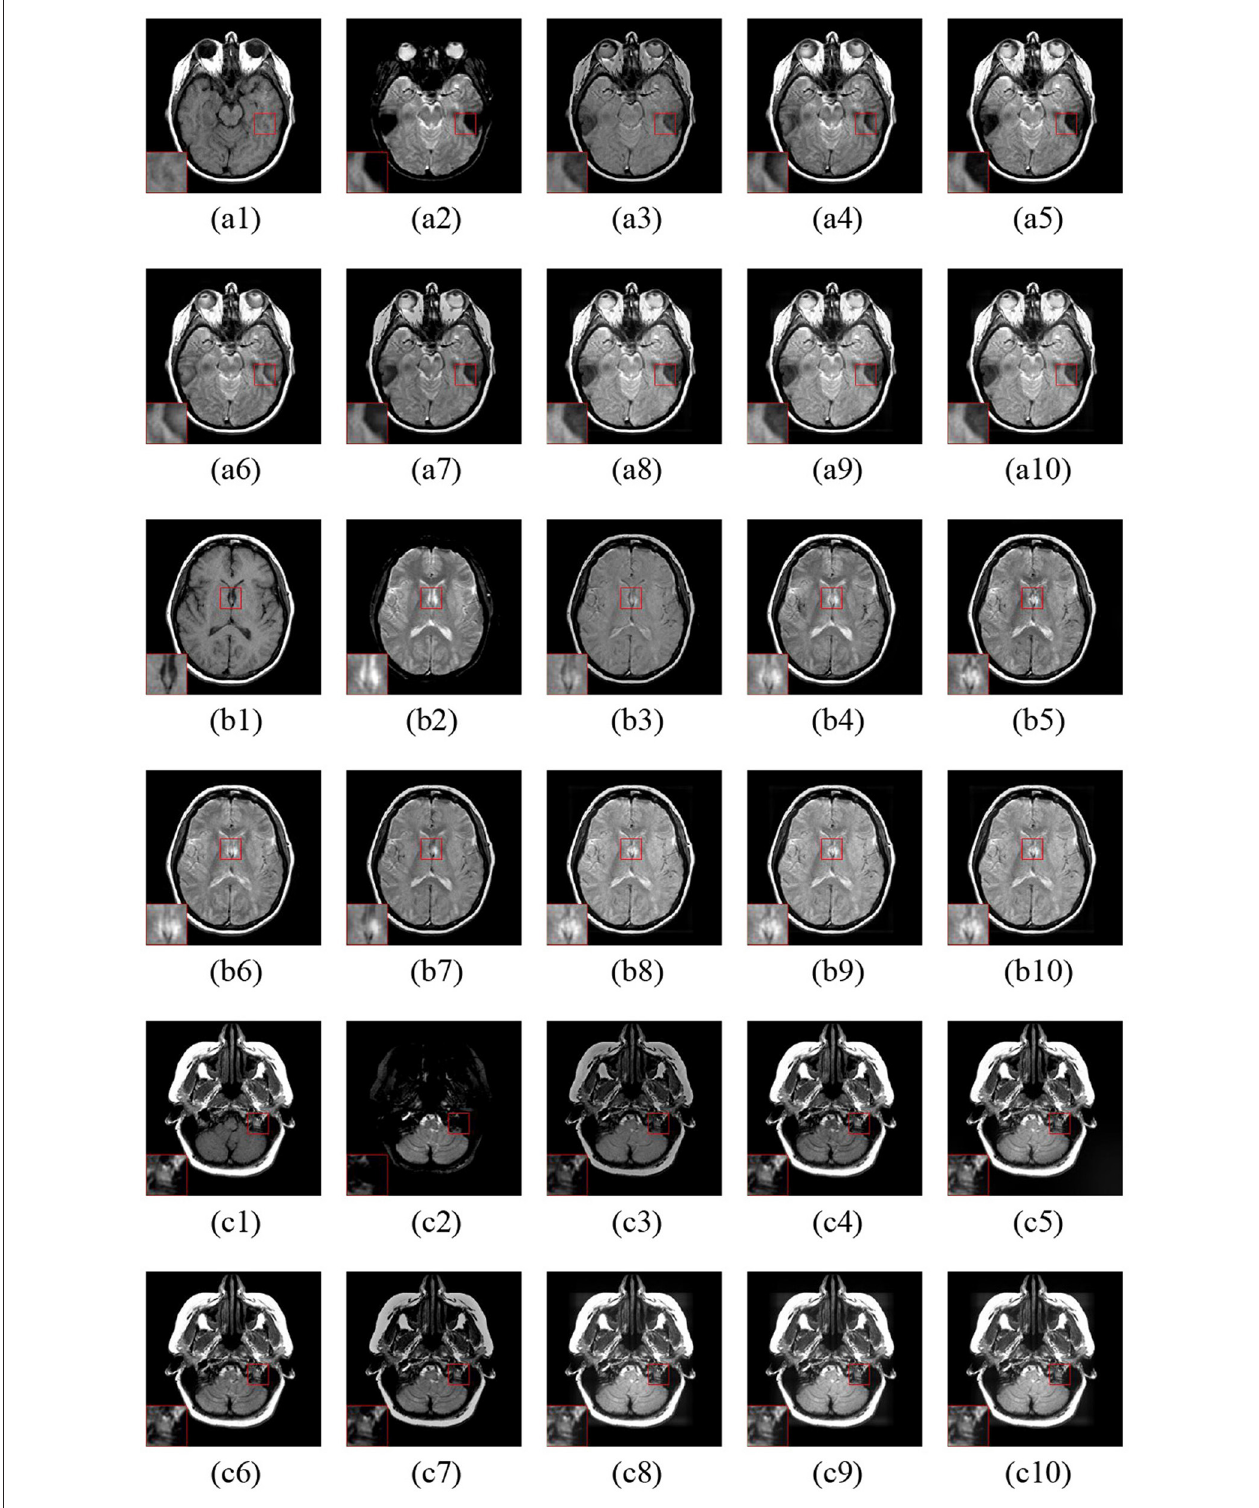
FIGURE 7 | Three fusion examples of MR-T1 and MR-T2 images. One close-up is provided in each set for better comparison. The original images: (a1–c1) MR-T1 and (a2–c2) MR-T2. The fusion results are as follows: (a3–c3) ASR, (a4–c4) NSCT-PC-LLE, (a5–c5) LP-CNN, (a6–c6) NSST-PAPCNN, (a7–c7) CSMCA, (A8–C8) LatLRR-FCN-32s, (a9–c9) LatLRR-FCN-16s, and (a10–c10) LatLRR-FCN-8s.